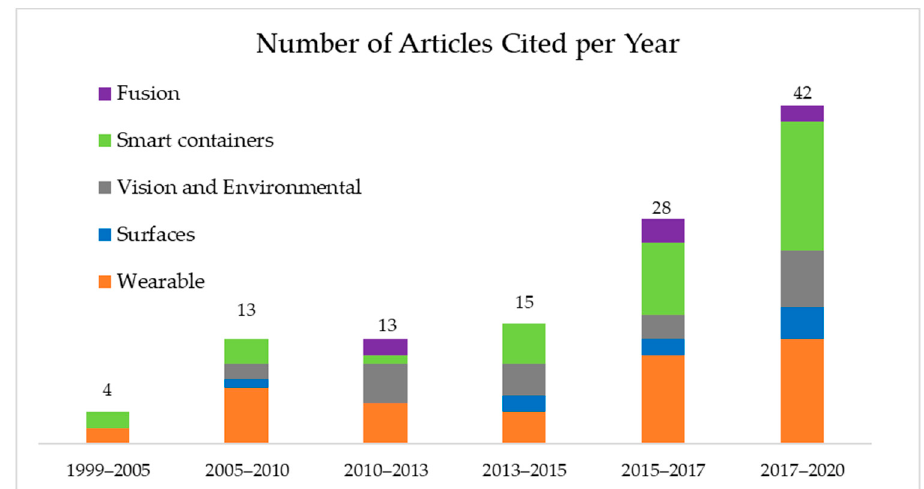
Figure 1. Number of articles reviewed per year.